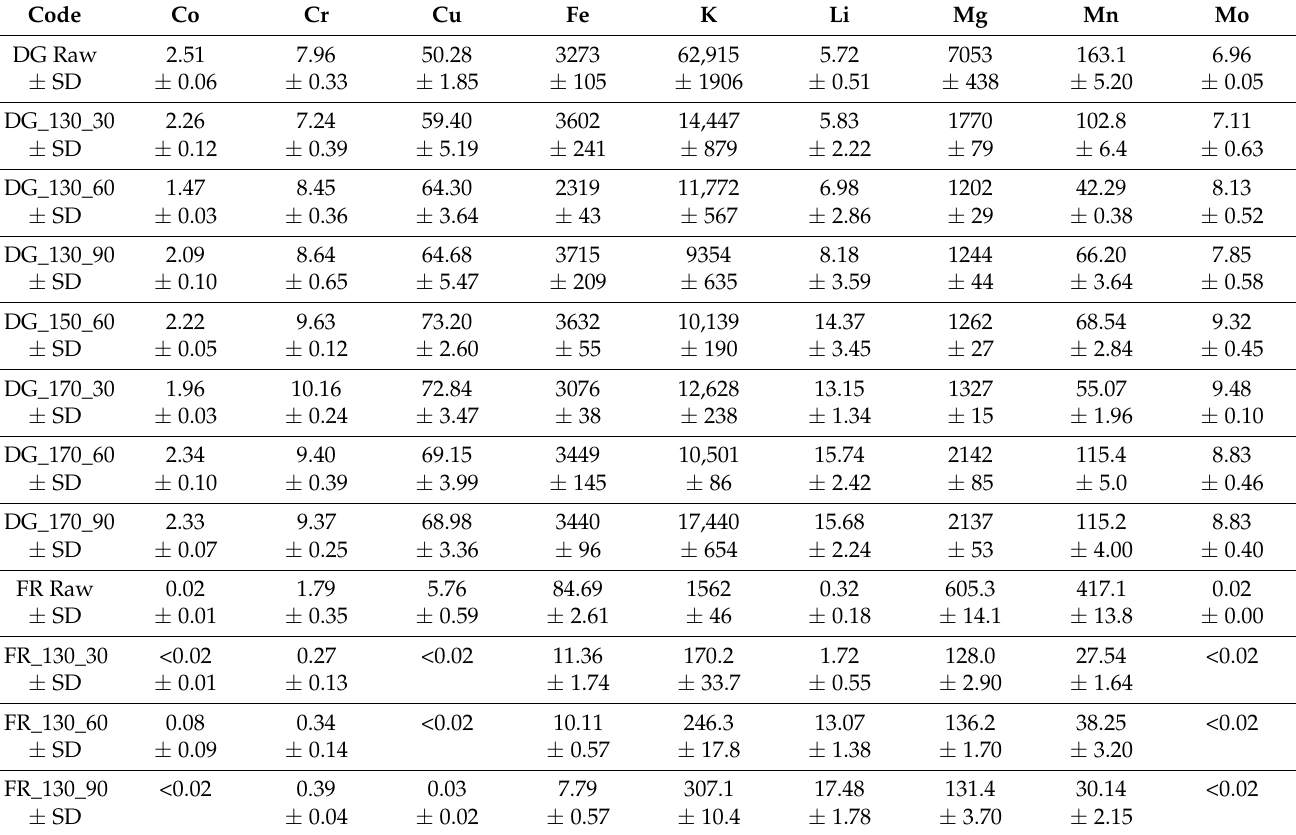
Table A3. Mean values ± standard deviations (SD) for different element concentrations in the digestate (DG) and forest residue (FR) hydrothermally treated at 130, 150 or 170 ◦ C with a holding time of 30, 60 or 90